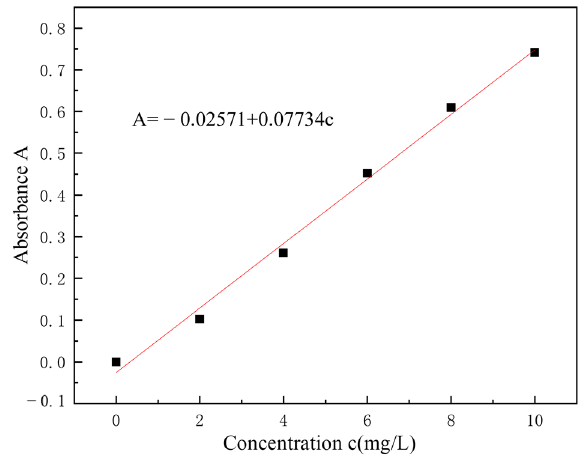
Figure 4. Standard curve of methyl orange solution. Methyl orange standard curve: A = − 0.02571 + 0.07734c, where A is the absorbance and c is the concentration of the solution.